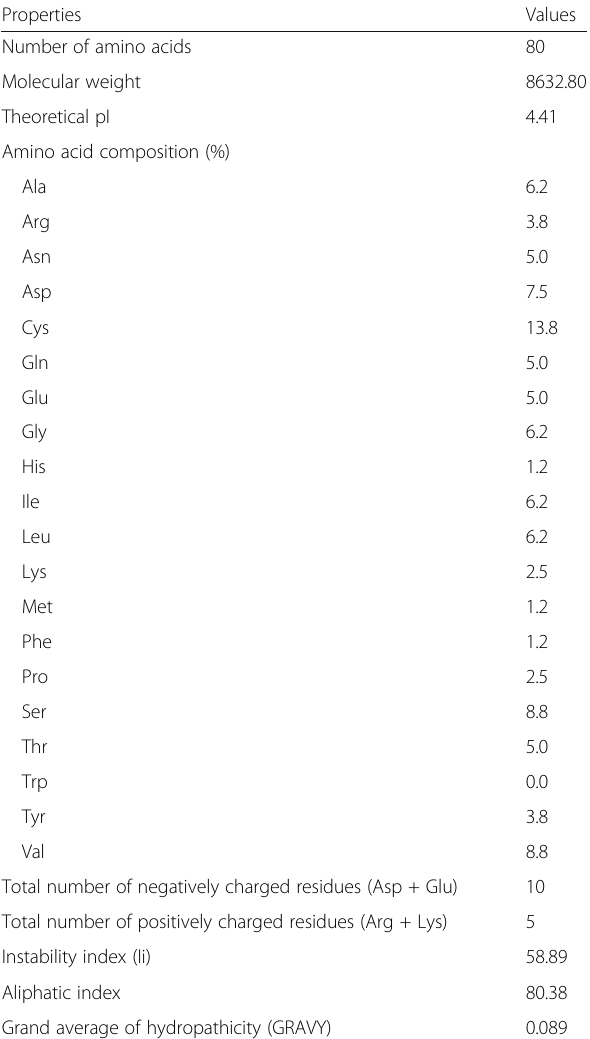
Table 2 Biochemical properties of the HaTIL2 protein sequence of Helicoverpa